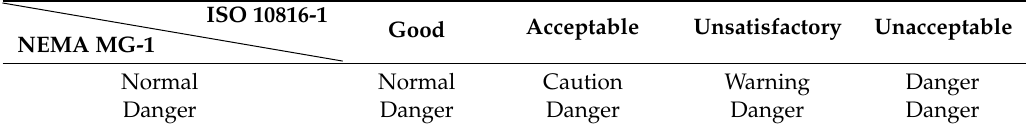
Table 4. Operating condition monitoring